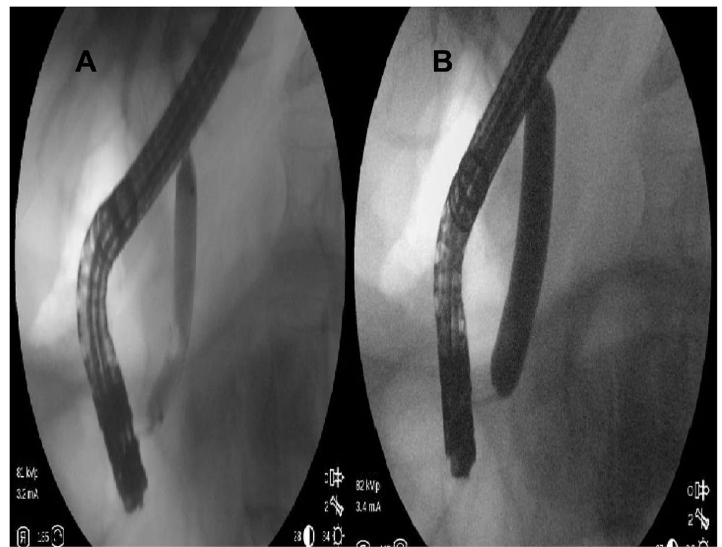
Fig. 2 Cholangiogram shows EPLBD. A The biliary sphincter is visible as a ‘waist’ during inflation of the balloon. B The biliary sphincter is adequately dilated when the balloon’s waist has completely